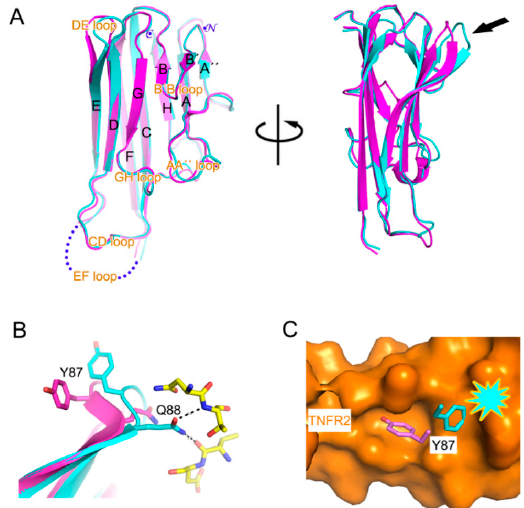
Figure 3. Conformational change of the DE loop. ( A ) Superposition of the TNF α protomers extracted from the TNF α -certolizumab complex (cyan) and the TNF α –TNFR2 complex (purple) in two orientations. The strands, loops, N-, and C-terminus of TNF α are labelled. The arrow indicates the discrepancy of the DE loop conformation; ( B ) Conformational change of the DE loop induced by certolizumab binding. The bidentate hydrogen bond by TNF α Q88 with certolizumab (yellow) changes the DE loop conformation; ( C ) Steric collision of TNF α Y87 with TNF α is represented in the case of the DE loop conformation altered by certolizumab binding. The surface of TNFR2 is colored orange.